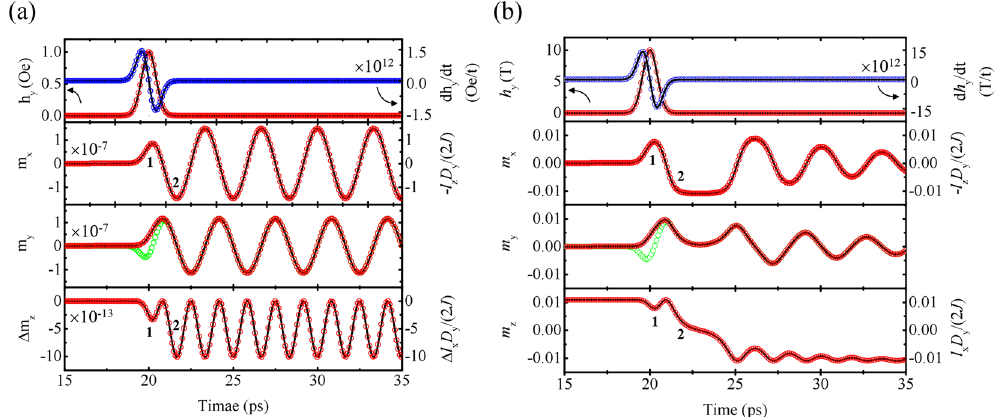
Figure 2. Analytical and numerical calculation results. ( a ) Excitation modes and ( b ) switching modes via a Gaussian-type magnetic pulse in a canted antiferromagnet. The solid line and open circles represent the numerical and analytical solution, respectively. Note that two tipping processes, denoted by 1 and 2 in m z and m x , are ascribed to the resonant effect by a single-cycle differential field, d h y /dt (blue), not by h y (red). Magnetization switching occurs by process 2. m y also shows two tipping processes (green) when the field- induced magnetization, Δ m y = gu B h y /(2 J ), is excluded.